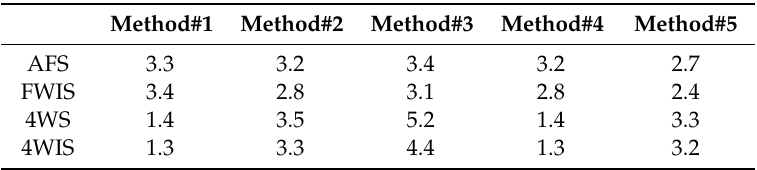
Table 2. Maximum absolute yaw rate error for each actuator and method.